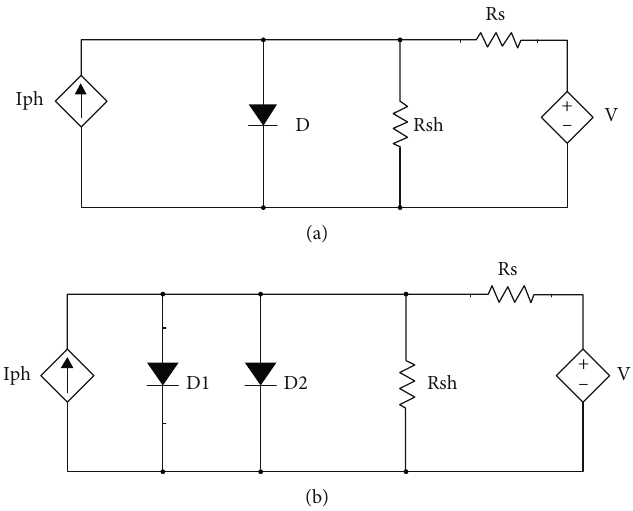
Figure 1: The equivalent circuit of photovoltaic cell: (a) one diode model; (b) two diode